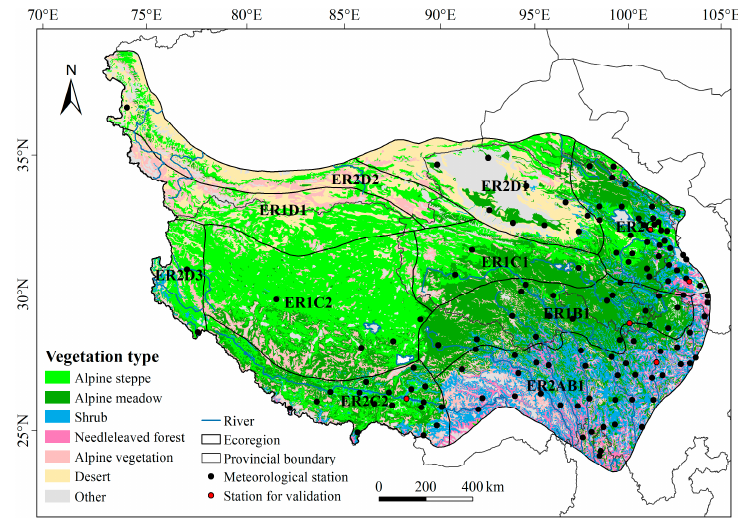
Figure 1. Location of the Tibetan Plateau and its vegetation types and eco-geographical regions. Table 1. The ecoregions of the Tibetan